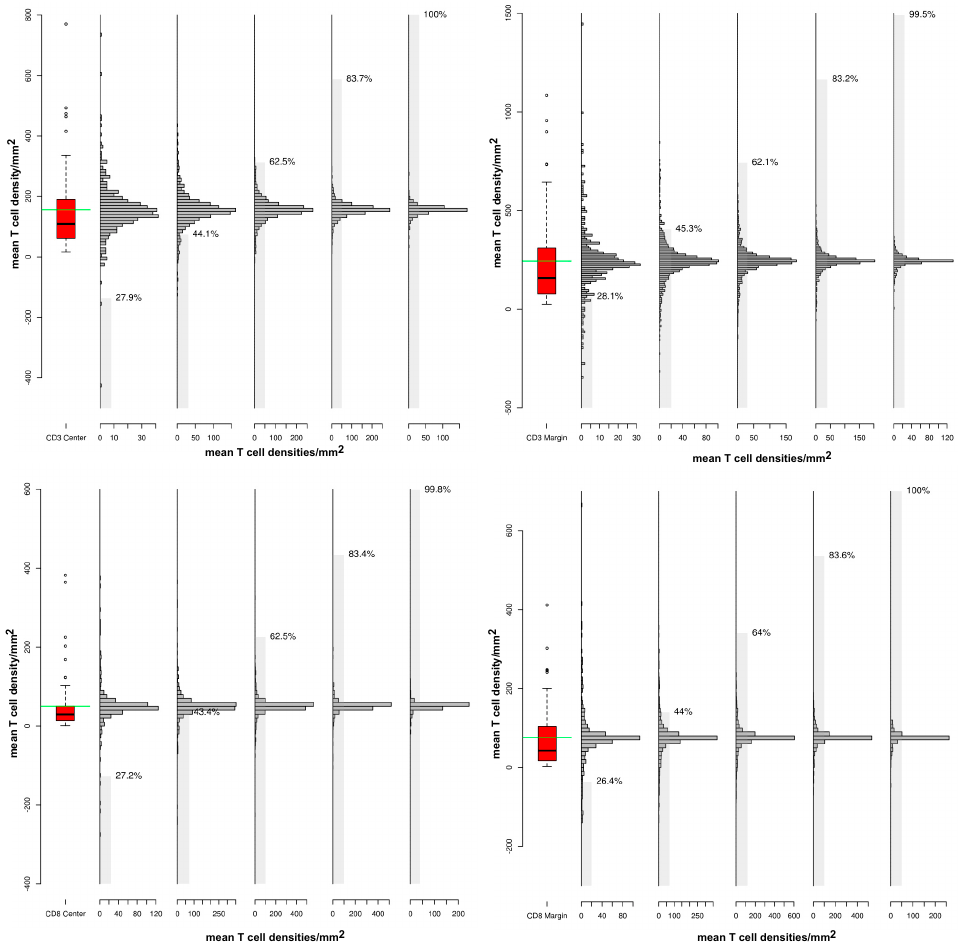
Figure 6. Variations in T cell densities based on the number of cores chosen for quantification by virtual tissue microarray. Quantification of mean T cell densities using 5 cores for each patient (bar graph) shows a higher range of variation compared to mean T cell densities using 6 cores from all patients (boxplot). Top : Tumoral CD3 density: range 0–350 (boxplot); 1 core: 0–40 (SE = 28.1%) vs. 5 cores: 0–150 (SE = 99.5%); marginal CD3 density: range 0–650 (boxplot); 1 core: 0–30 (SE = 27.9%) vs. 5 cores 0–120 (SE = 100%). Bottom : Marginal CD8 density: range 0–100 (boxplot); 1 core: 0–120 (SE = 27.2%) vs. 5 cores 0-200 (SE = 99.8%); tumoral CD8 density: range 0–200 (boxplot); 1 core: 0–100 (SE = 26.4%) vs. 5 cores: 0-250 (SE = 100%). Note. Range - range of variation in T cell density; SE—standard error.